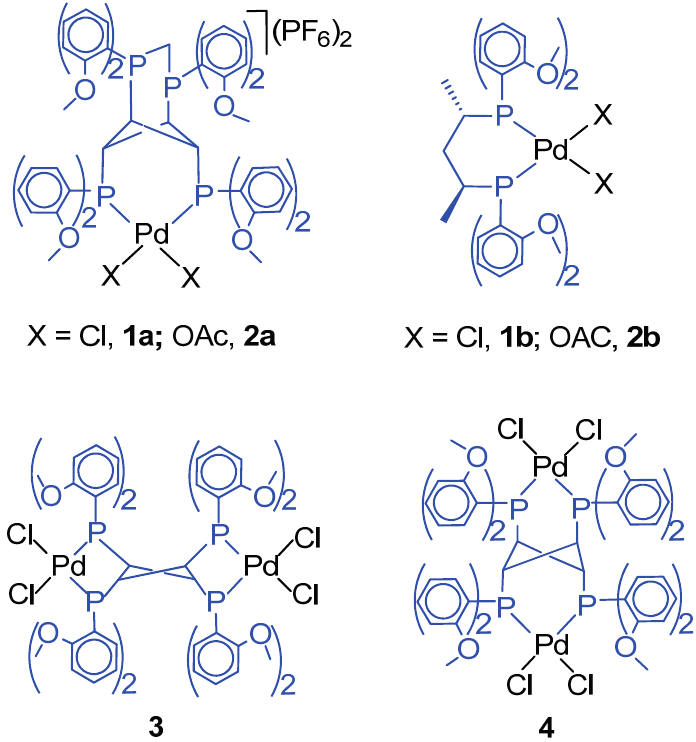
Figure 8. Catalysts with ligands of different stereochemical